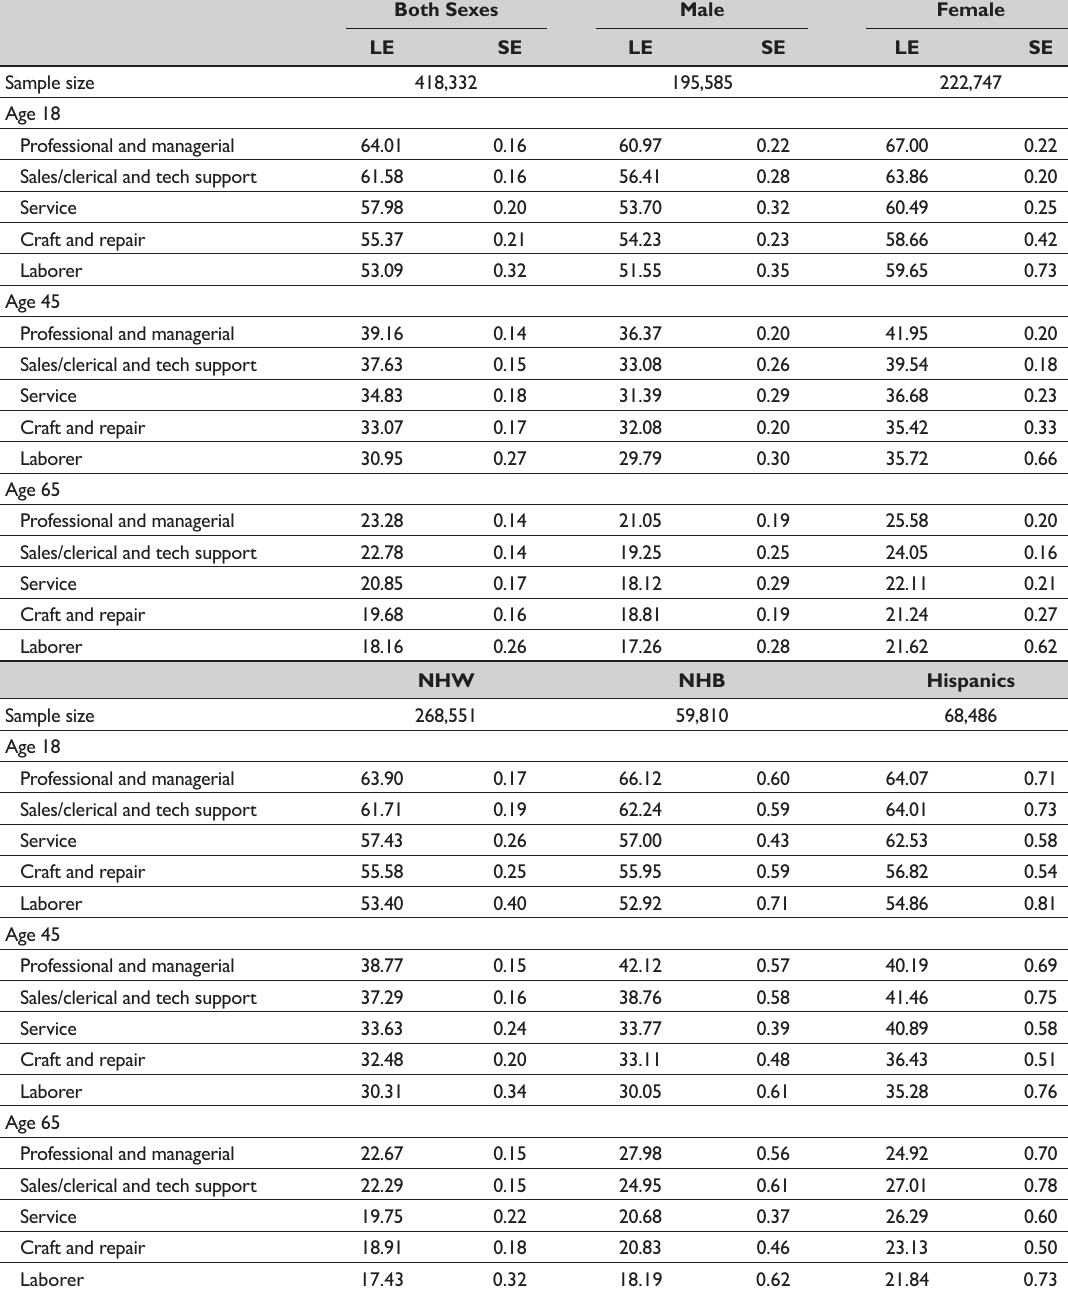
Table 3: Estimated life expectancies at selected ages at baseline by occupation 1 , United States, 1997-2014 Both Sexes Male Female LE